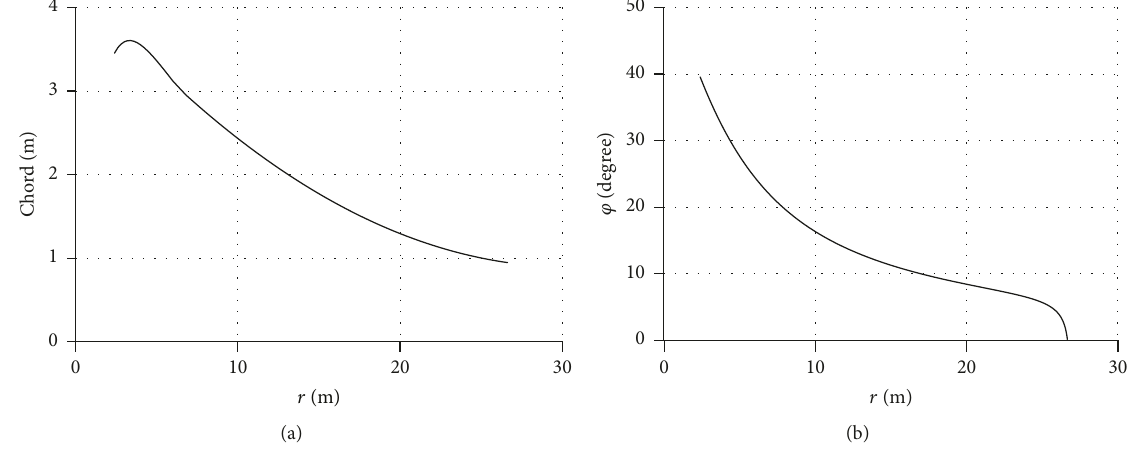
Figure 5: Variation of (a) chord and (b) 𝜑 during the blade.